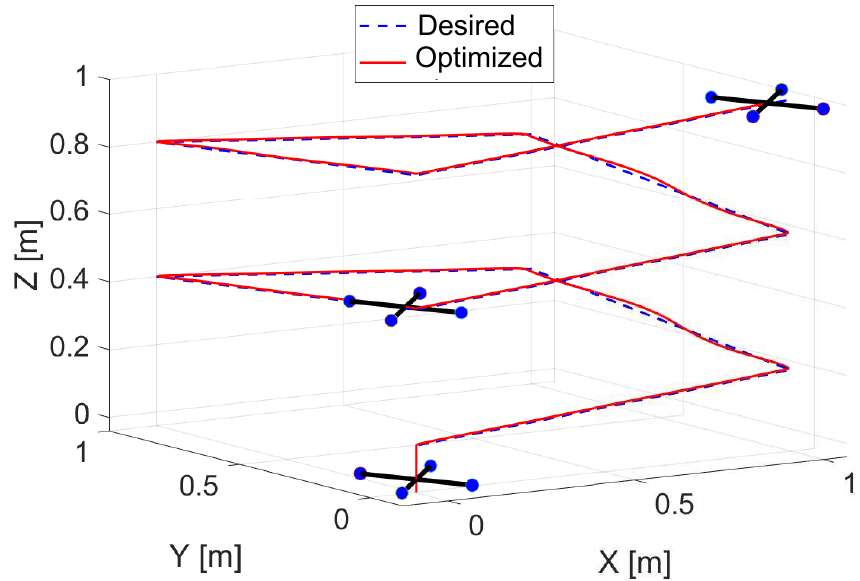
Figure 13. Tracking performance in three-dimensional space with optimized parameters using HGS